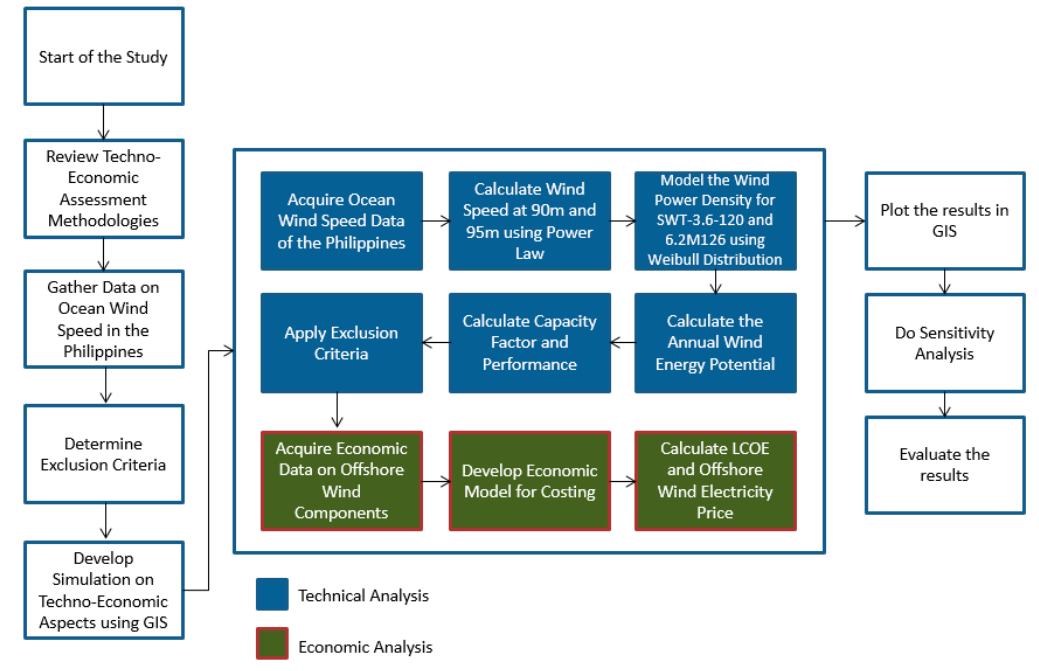
Figure 1. Framework of methodology.